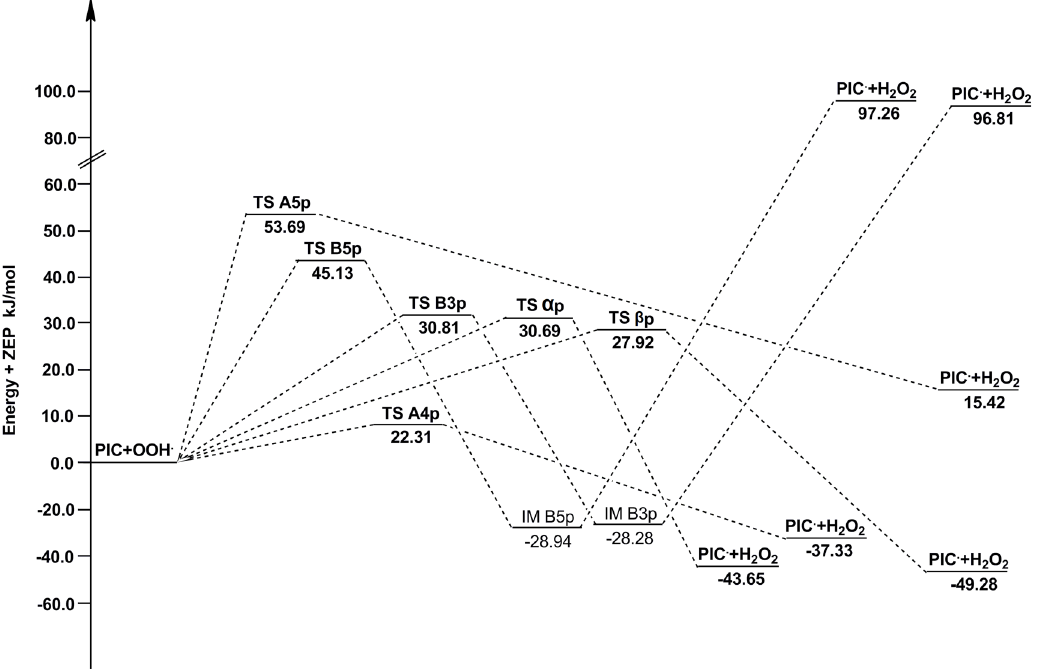
Fig 9. The potential energy surfaces of the reactions of PIC with (cid:129) OOH in the gas phase. The relative energies (in kJ/mol) were calculated at the M05- 2X/6-311++G(d,p) + ZPE level. To facilitate comparisons, the energy of the reactants are set to zero.